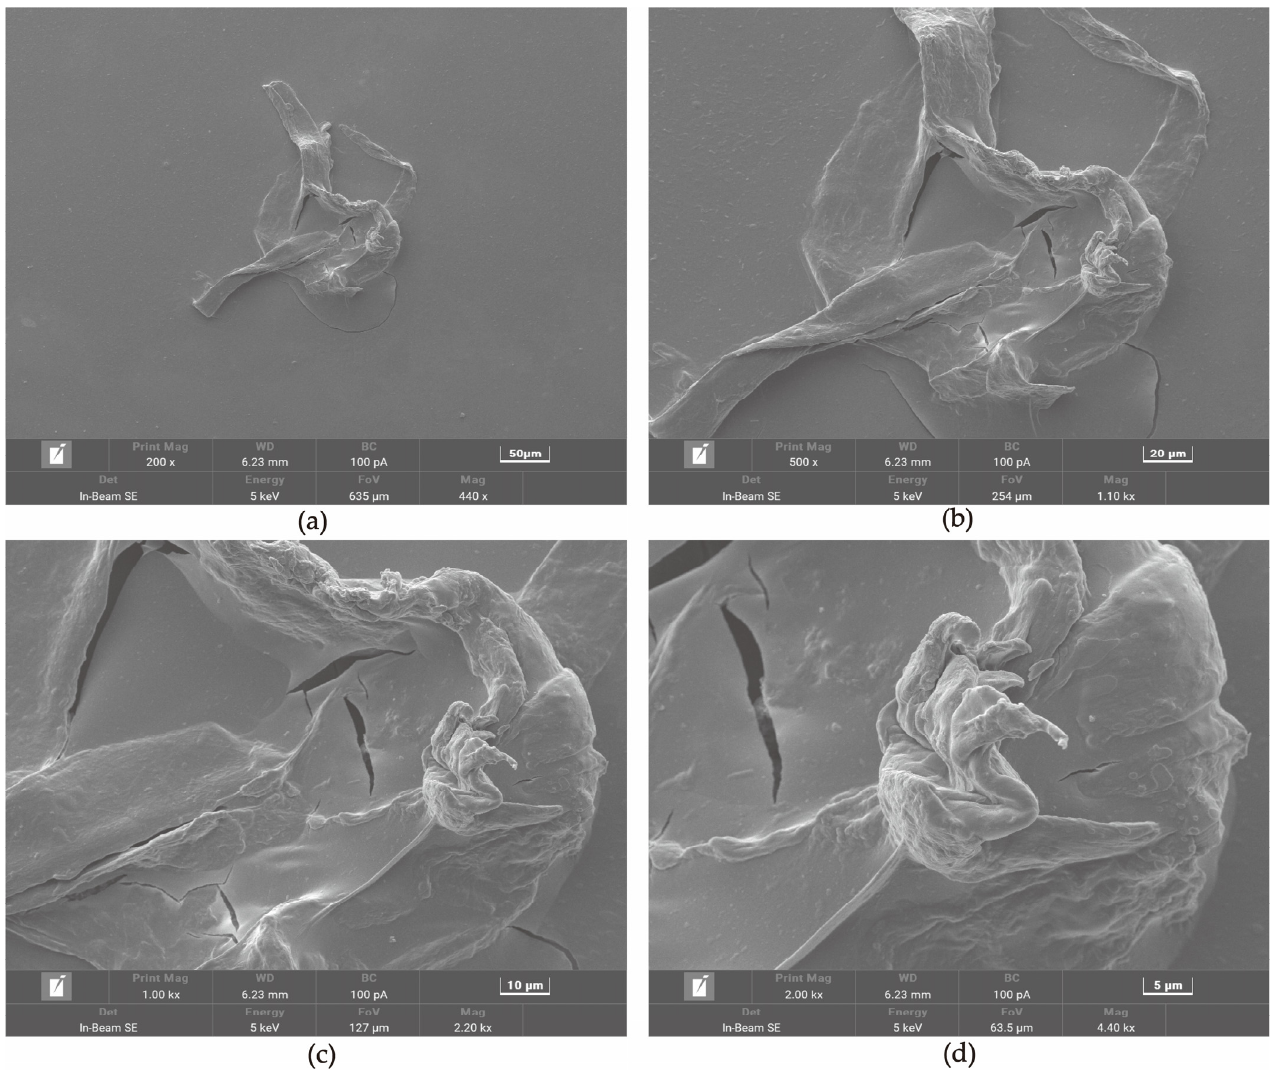
Figure 2. Microstructure of CHP at different magnifications. The sample was magnified by 200, 500, 1000, and 2000 times, ( a – d ).